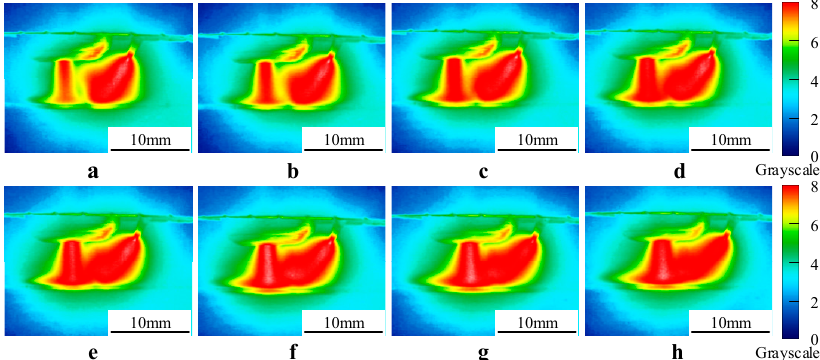
Figure 5. Acquired images of coupled arc profile with different TIG welding current: ( a ) 30 A; ( b ) 40 A; ( c ) 50 A; ( d ) 60 A; ( e ) 70 A; ( f ) 80 A; ( g ) 90 A; ( h ) 100 A.